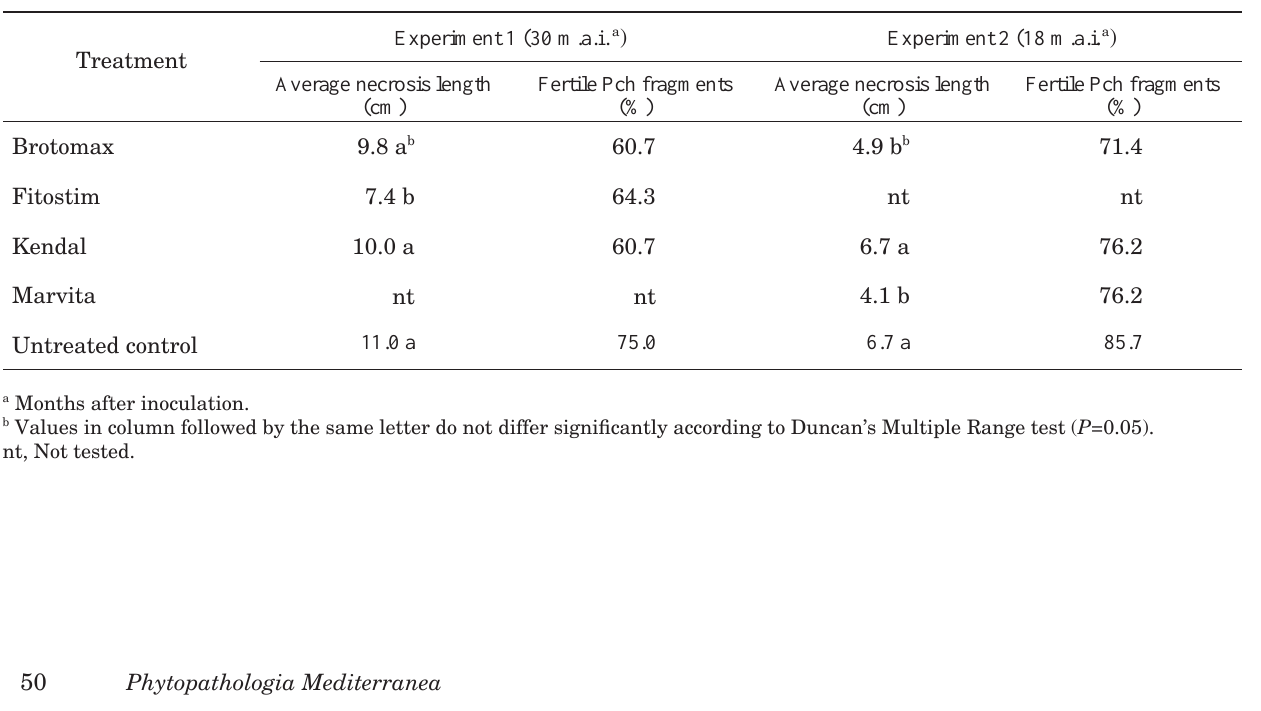
Table 2. Effects of sprays of biostimulants on Phaeomoniella chlamydospora (Pch) inoculated in the trunk of potted grafted